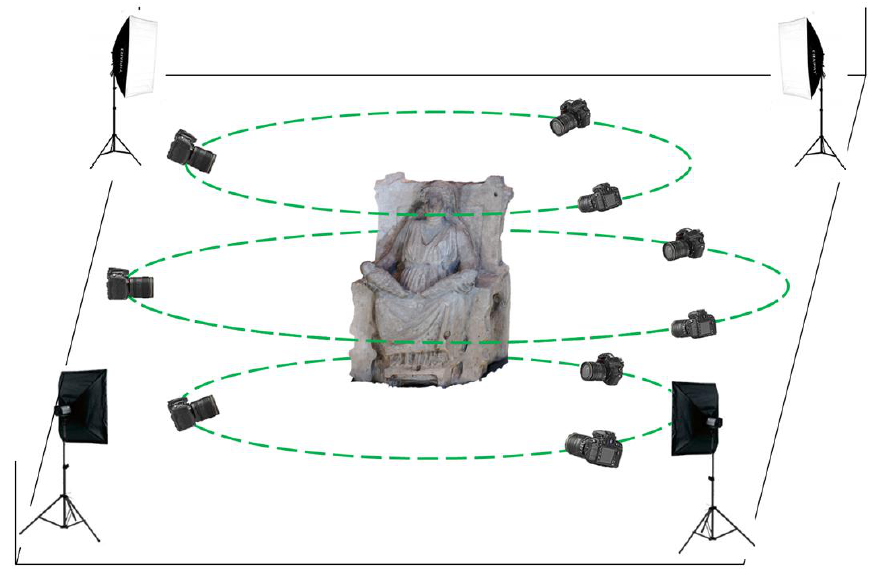
Figure 4. Layout of the photogrammetric acquisition area.